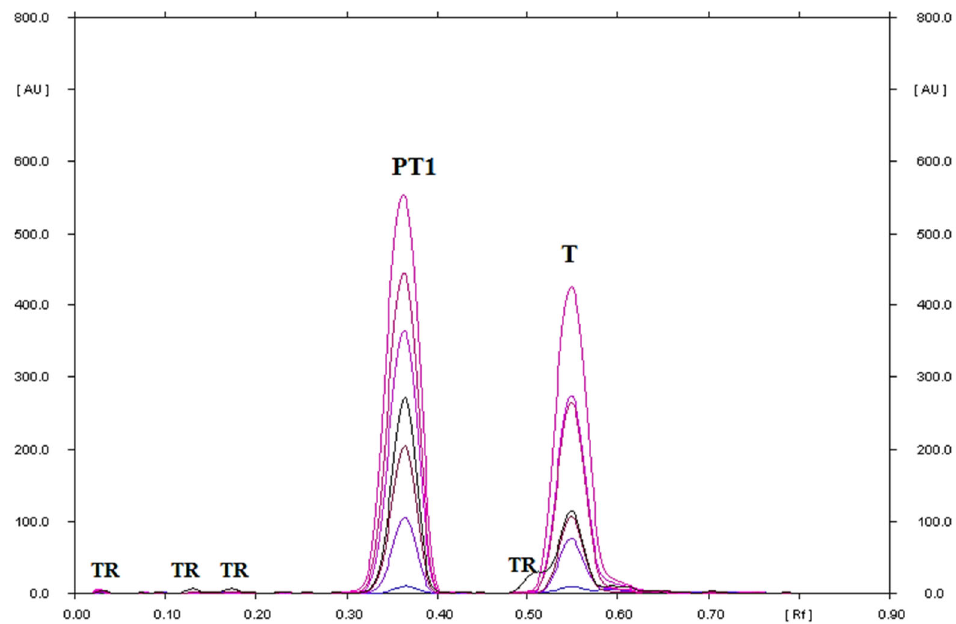
Figure 4. TLC-UV densitograms recorded in the multi wavelength from 200 to 380 nm (at wavelength intervals of 30 nm at each step) of tinidazole heated on silica gel at 120 °C for 24 which was next separating using chloroform–methanol (9:1, v / v ) as mobile phase, where: T is tinidazole, PT1 is the degradation product of tinidazole identified as 2-methyl-5-nitroimidazole, and TR is the traces. N